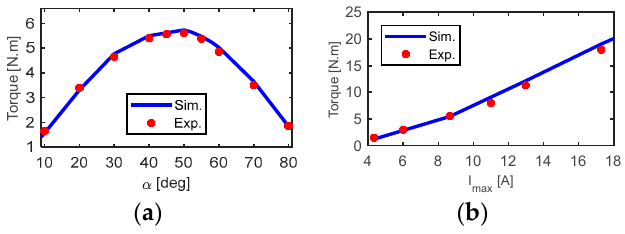
Figure 15. Measured and simulated average torque at ( a ) different current angles and 8.65 A and ( b ) different line currents and optimal current angles.